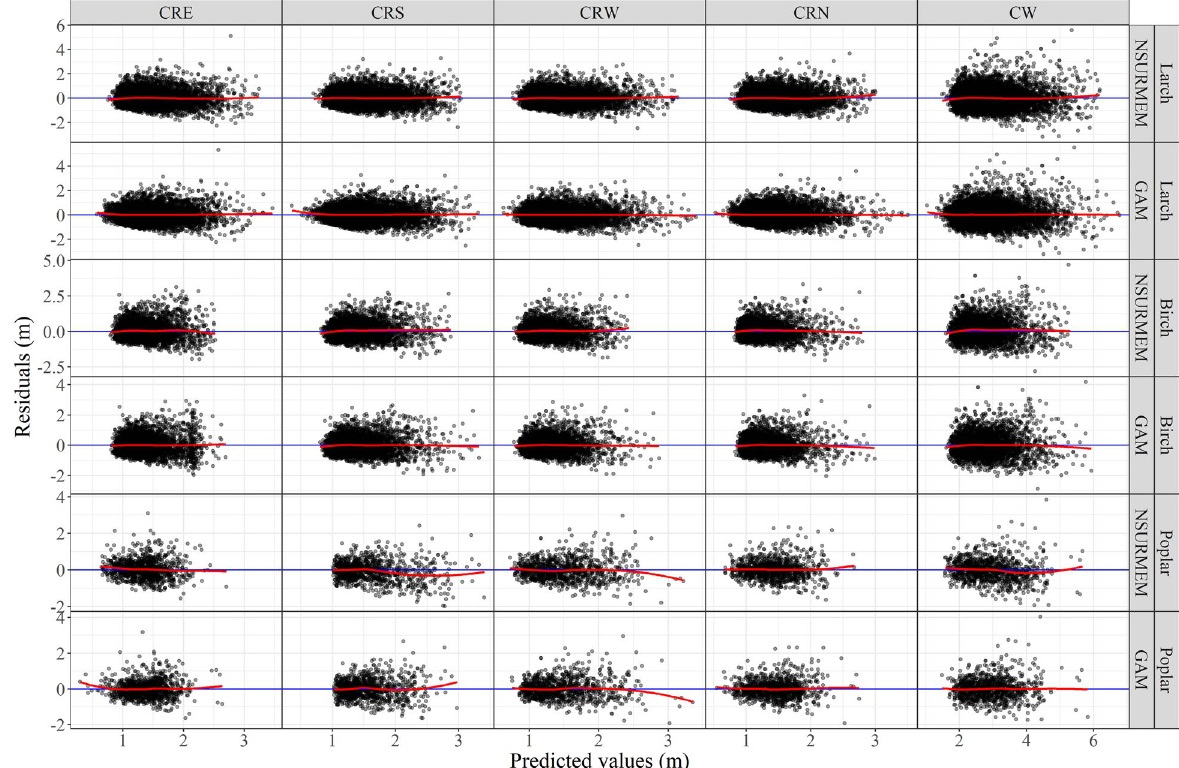
Fig. 7 Multi-panel display of residuals versus predicted values of NSURMEM and GAM systems for larch, birch, and